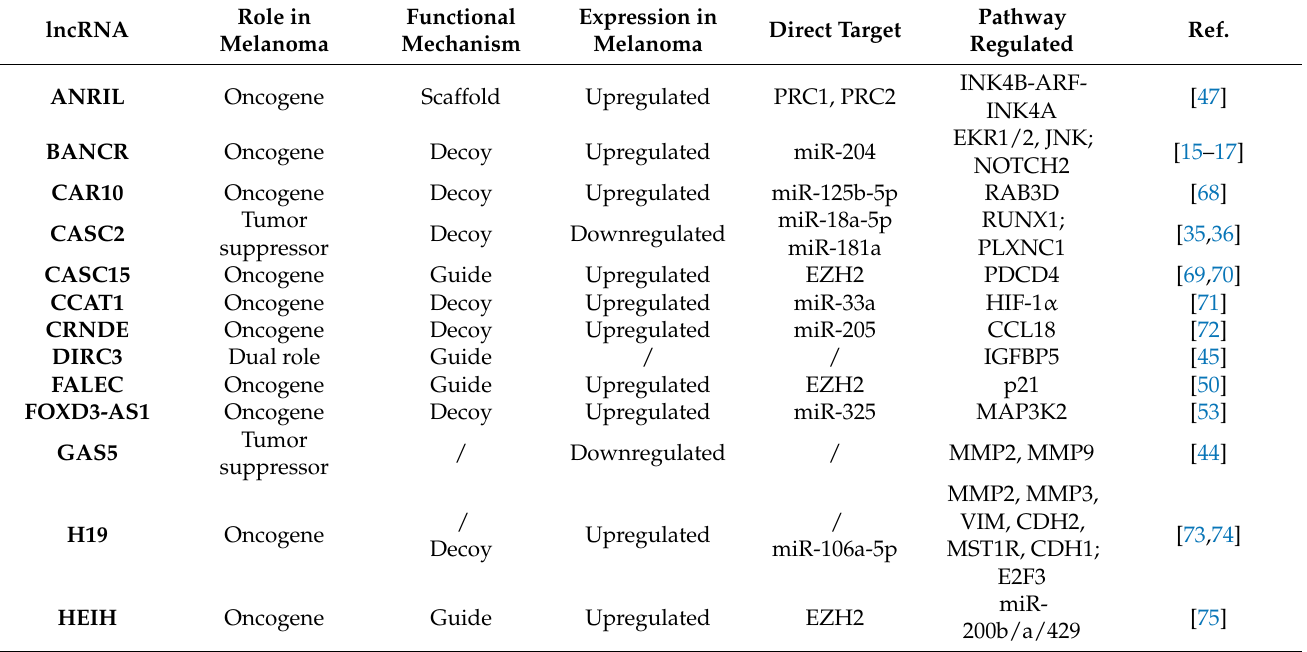
Table 1. Main lncRNAs with a putative function in